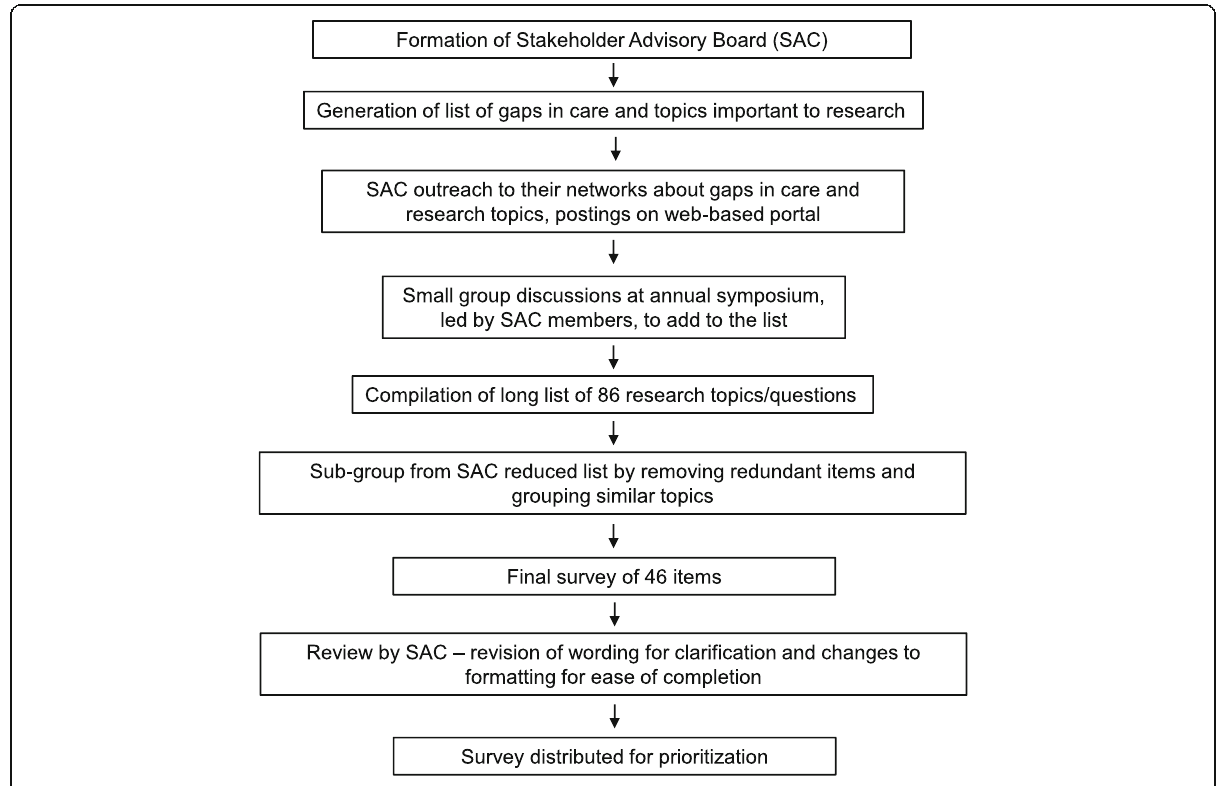
Fig. 1 Overview of Process to Develop Survey of Topics Important to Dementia Care